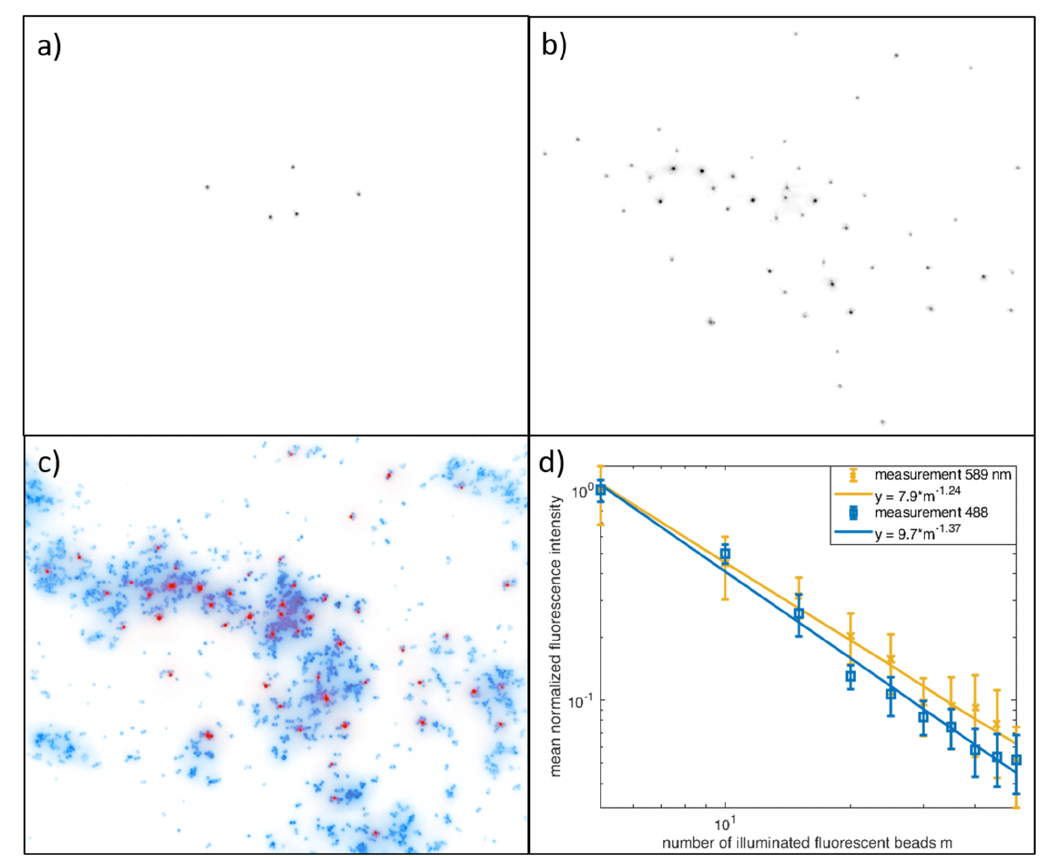
Figure 5. Excitation of fluorescent beads placed as a monolayer on a microscope slide. ( a , b ) 5 and 50 simultaneously illuminated beads, respectively. There is negligible crosstalk between stimulated and unstimulated particles Colors inverted for better visibility. ( c ) Wide-field illumination of the sample showing densely packed beads in blue. Locations of illuminated beads are superposed in red. ( d ) Normalized mean intensity of the excited fluorescent beads over the number of simultaneously illuminated particles. Measurements for the blue laser are marked as blue squares, measurements for the yellow laser are marked as yellow crosses. Error bars show the standard deviations. Linear fits to the logarithmic data are shown as solid lines.